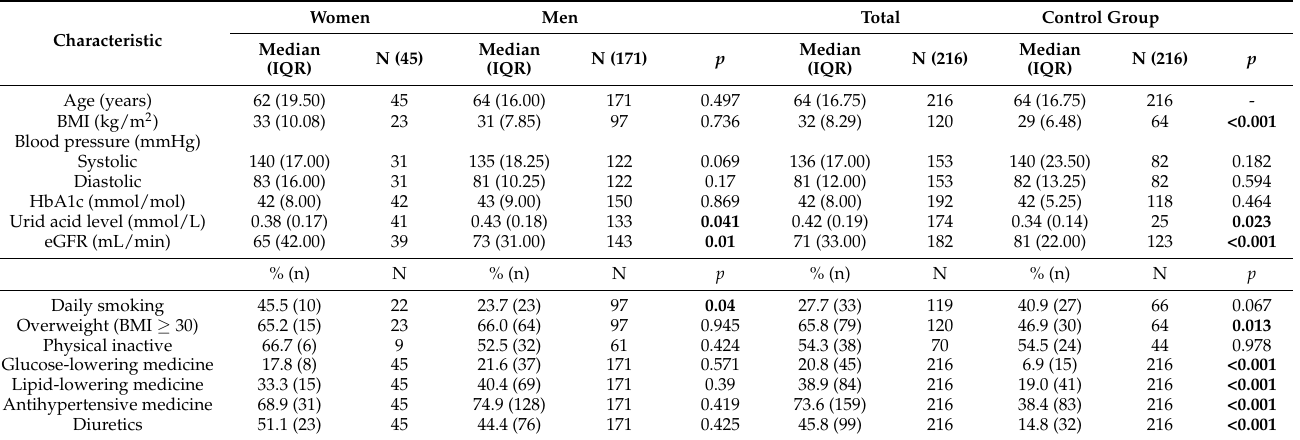
Table 2. Characteristics of patients treated with allopurinol in Greenland (women and men) and a control group matched on age and